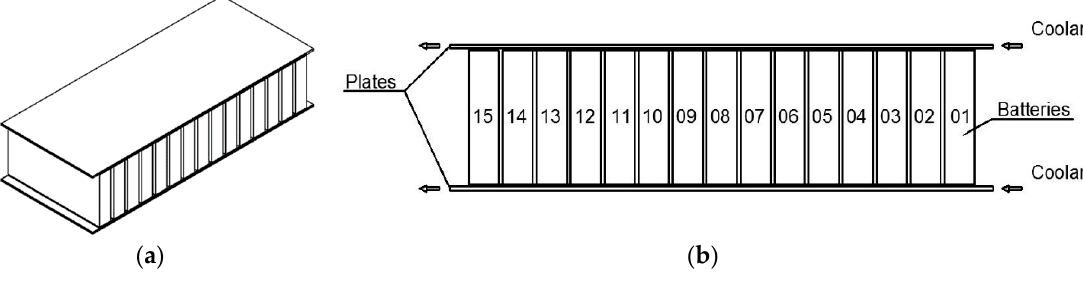
Figure 7. ( a ) Simplified CATIA model; ( b ) battery arrangement.